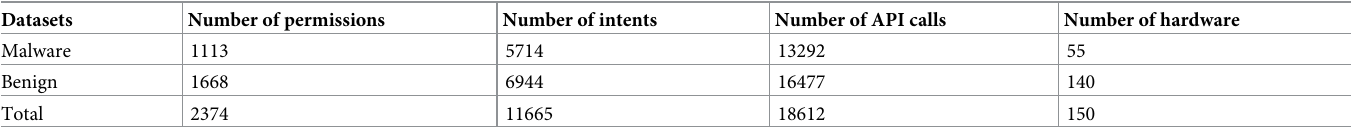
Table 3. The details of the extracted features.